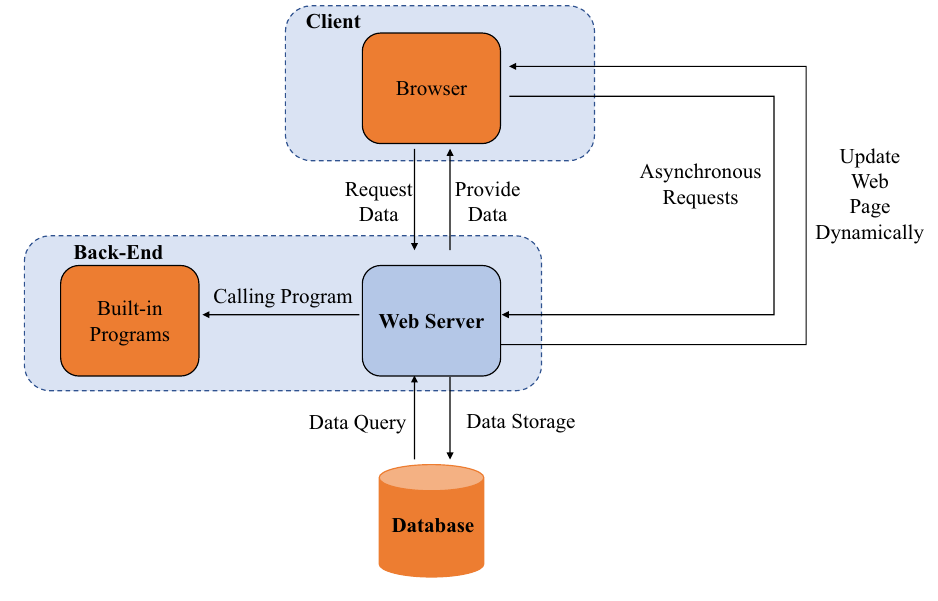
Figure 1. The browser/server architecture of